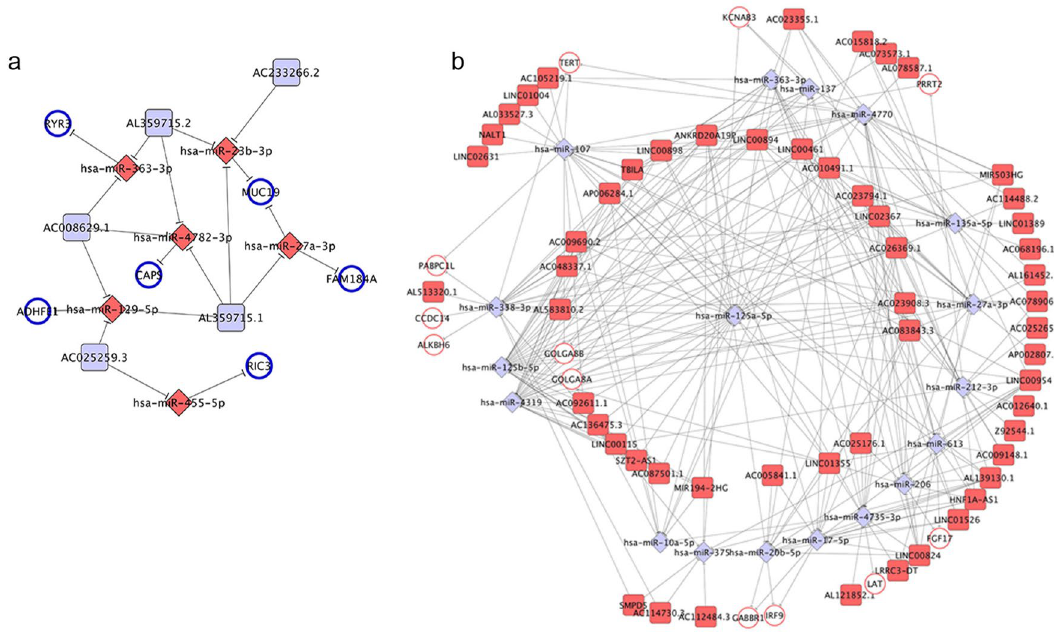
Figure 6. LncRNA-miRNA-mRNA ceRNA network. ( a ) Under-expressed network. ( b ) Over-expressed network. Blue and red color nodes represented downregulated and upregulated RNAs, respectively. Circle represented mRNA, and rhombus represented miRNA and round rectangle represented lncRNA.